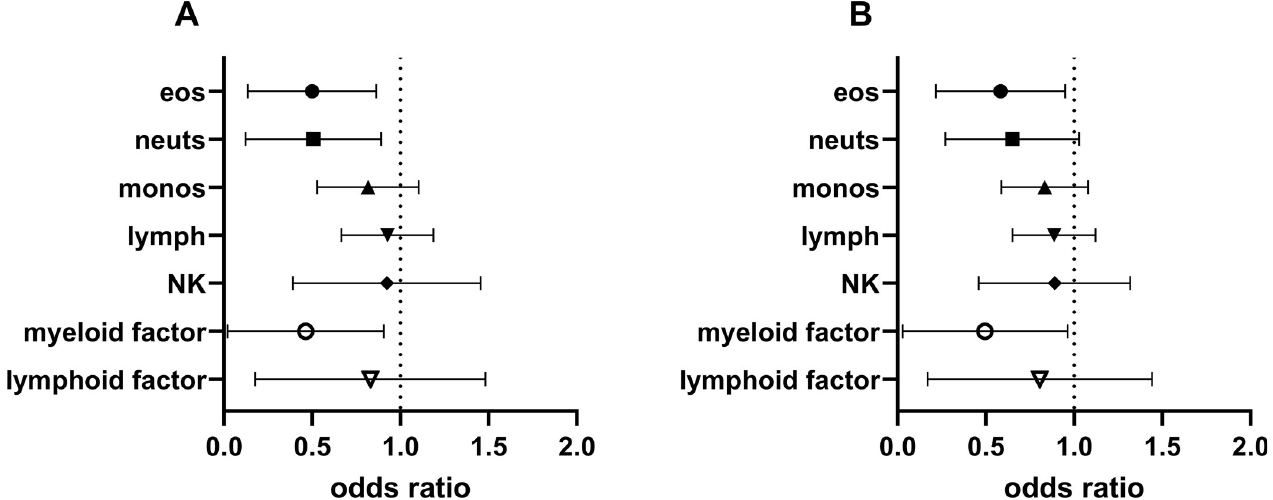
Fig 4. Odds ratios of CD41-positive leukocytes or PCA factors for PEC < 6 at V2. Odds ratios and 95% confidence intervals from logistic regression. A) With V2 data, p for eosinophils = 0.02, neutrophils = 0.03, monocytes = 0.18, lymphocytes = 0.48, NK cells = 0.52, myeloid factor = 0.04, lymphoid factor = 0.34. B) With V2-V1 data, p for eosinophils = 0.04, neutrophils = 0.08, monocytes = 0.16, lymphocytes = 0.28, NK cells = 0.43, myeloid factor = 0.06, lymphoid factor = 0.30. Eos, eosinophils; lymph, lymphocytes; monos, monocytes; neuts, neutrophils; NK, natural killer cells; PCA, principal component